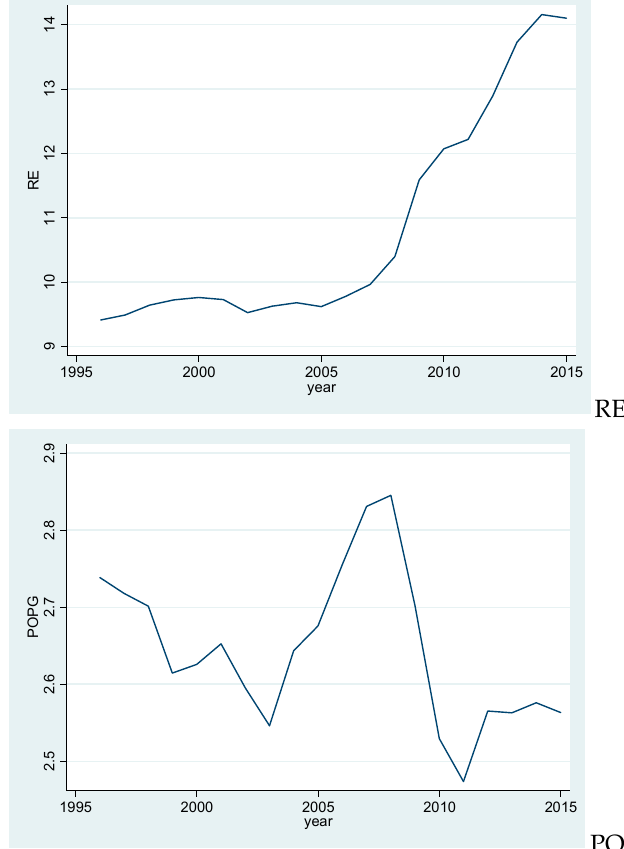
Figure 1. Pretest analysis: time series of the variables between 1995 and 2015.